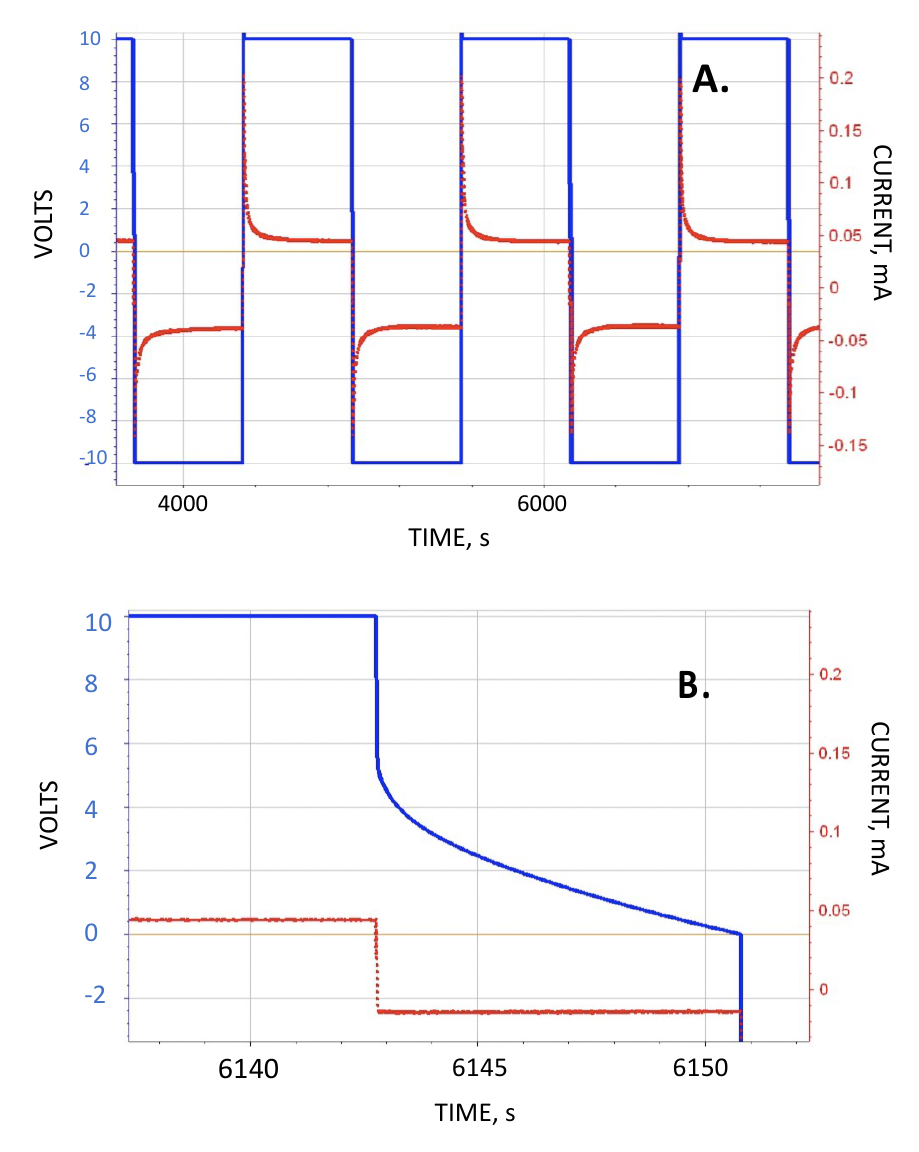
Figure 2. Discharge of DI-DOC for a 20 mm separation capacitor. ( A ) Four positive (10 V to 0 Volts) and three negative ( − 10 V to 0 V) voltage cycles shown. The hold time at maximum voltage was 600 s, and the constant current discharge current was 0.02 mA. ( B ) An expansion of one of the positive discharges shows that the discharge from 1 V to 0 V took approximately 3 s. The computed capacitance (Equation (1)) below one volt, 6 × 10 − 5 F, was about eight orders of magnitude higher than that computed for the same capacitor sitting on the lab bench. (Lines: Red current, blue voltage).